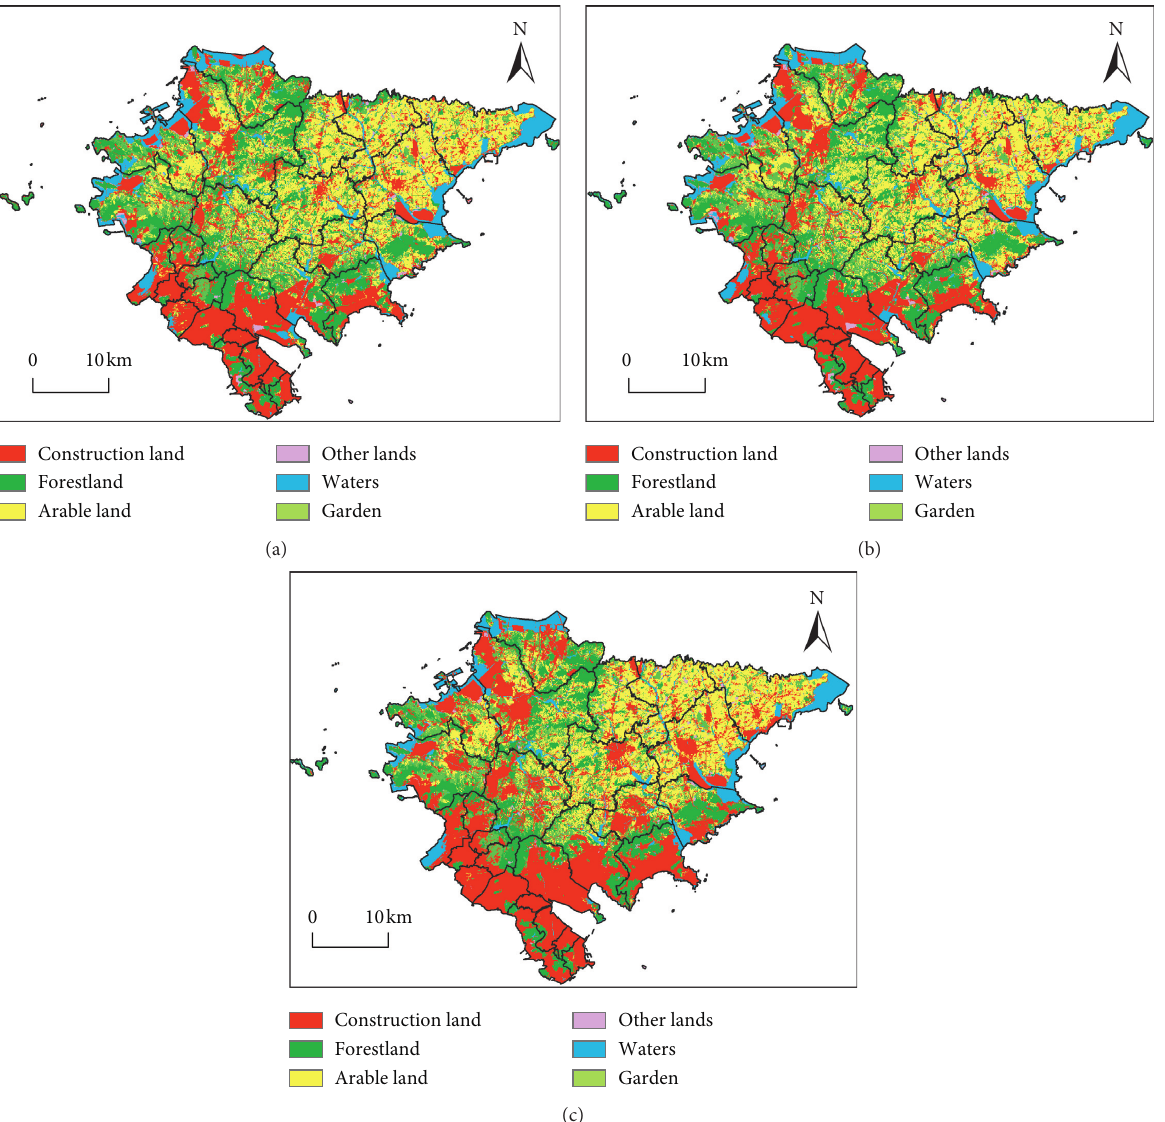
Figure 7: Land use simulation results. (a) Nonzoning simulation 2016. (b) Zoning simulation 2016. (c) Zoning simulation 2020. Table 6: Accuracy comparison of land use simulation.